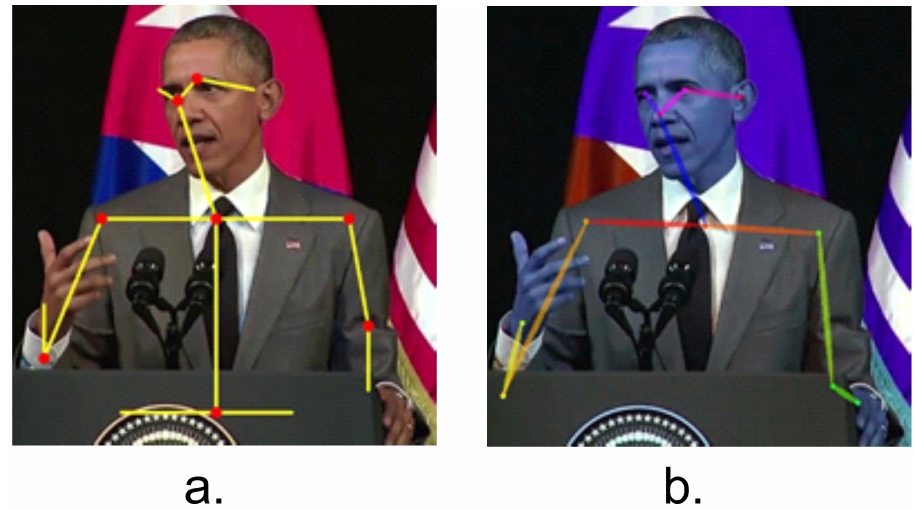
Figure 5. Sample Pose’s Keypoint Extraction: ( a. ) Using the BODY_25 model of OpenPose and the DNN module of OpenCV. ( b. ) Using the PyTorch COCO model of PyTorch-OpenPose. OpenCV is used for the frame reading and PyTorch-OpenPose for pose estimation.